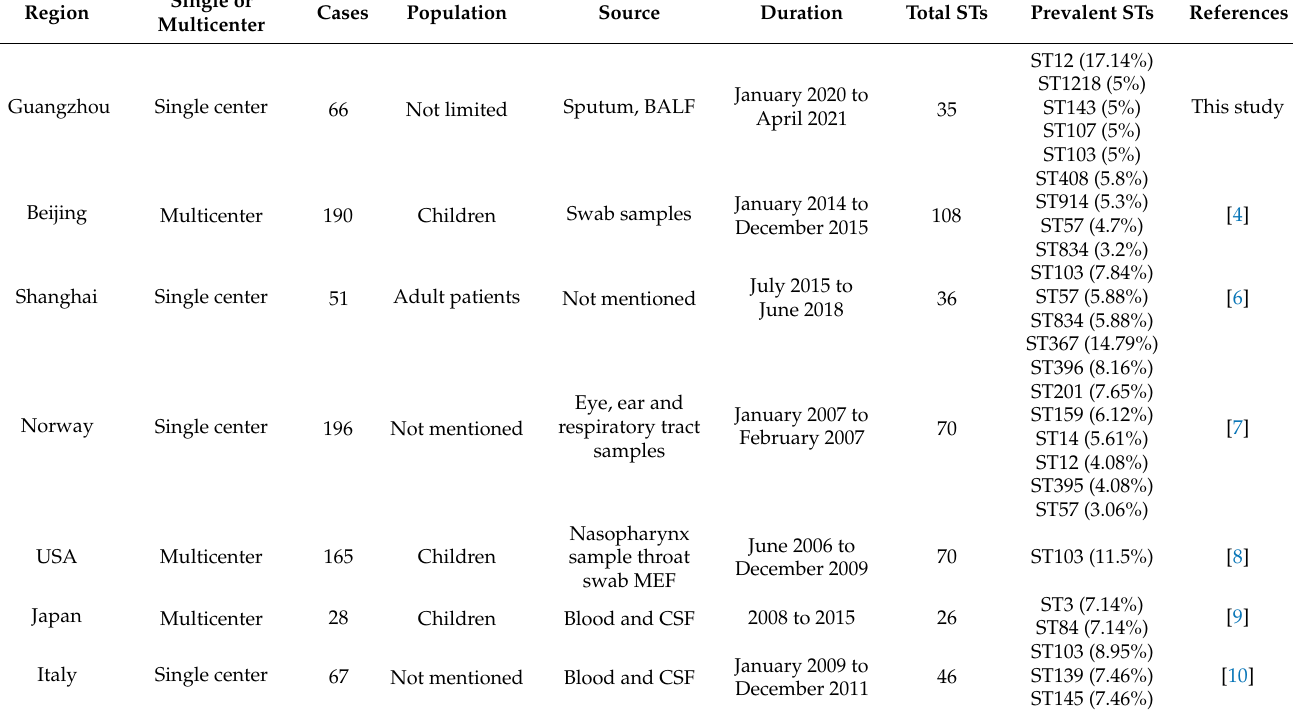
Table 2. Occurrence and prevalence of NTHi in different